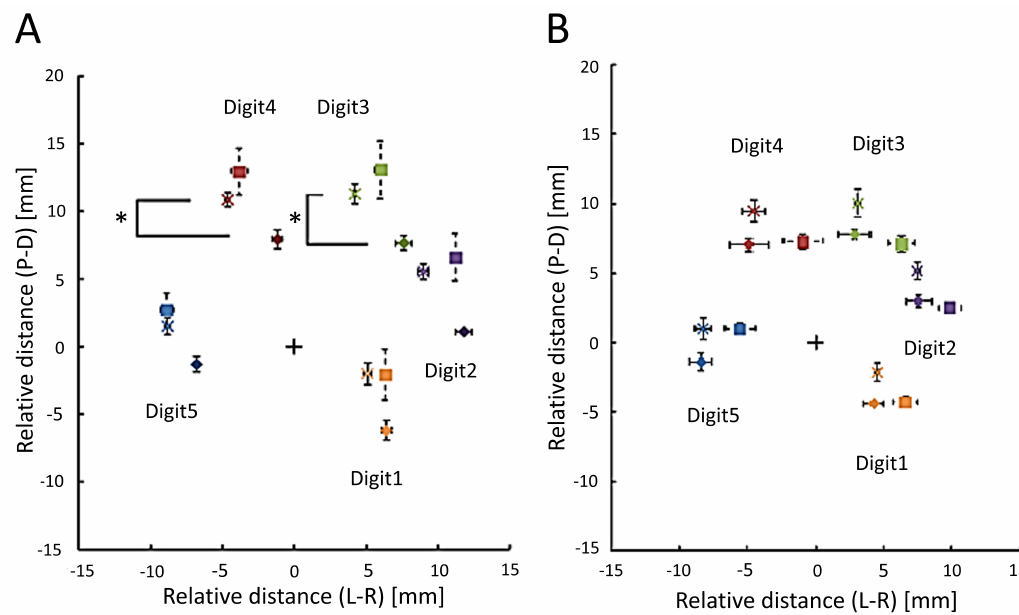
Fig. 10. The separation between each fingertip and the center of the pellet. Variation is seen in the position of each fingertip when the rats touch the pellet during the RT (A: males, B: females). The fingertips of each digit are shown in different colors. The + mark at the center (0, 0) indicates the center of the pellet (the point of origin). The animal is left-handed. The positive numbers in the x-axis show the right direction and, in the y-axis, the distal direction. Diamonds ( ♦ ) indicate the pre-lesion values, and squares ( ■ ) and crosses ( ⊗ ) indicate the values at the 6th and 15th days after the cortical lesion, respectively. Data are represented as mean ±